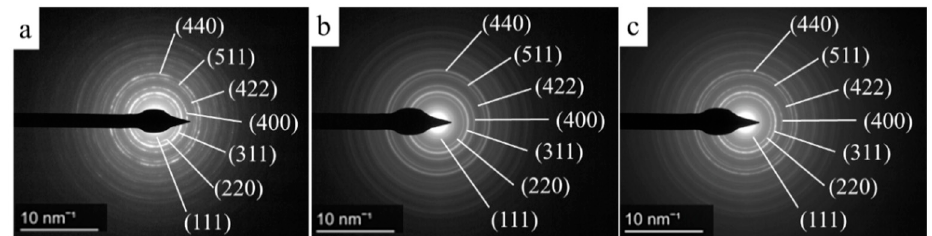
Figure 2. Electron diffraction patterns of the CoFe 2 O 4 -NH 2 ( a ), CdFe 2 O 4 -NH 2 ( b ) and NiFe 2 O 4 -NH 2 ( c ) with the Miller indexes (PDF 89-2810; PDF 22-1086 and PDF 10-0325). To map the surface functionality and structure of the amine functionalized ferrite nanoparticles Fourier-transform infrared (FTIR) spectra were recorded. In the spectra and 600 cm − 1 and between 400 cm − 1 and 450 cm − 1 which belong to the tetrahedral and